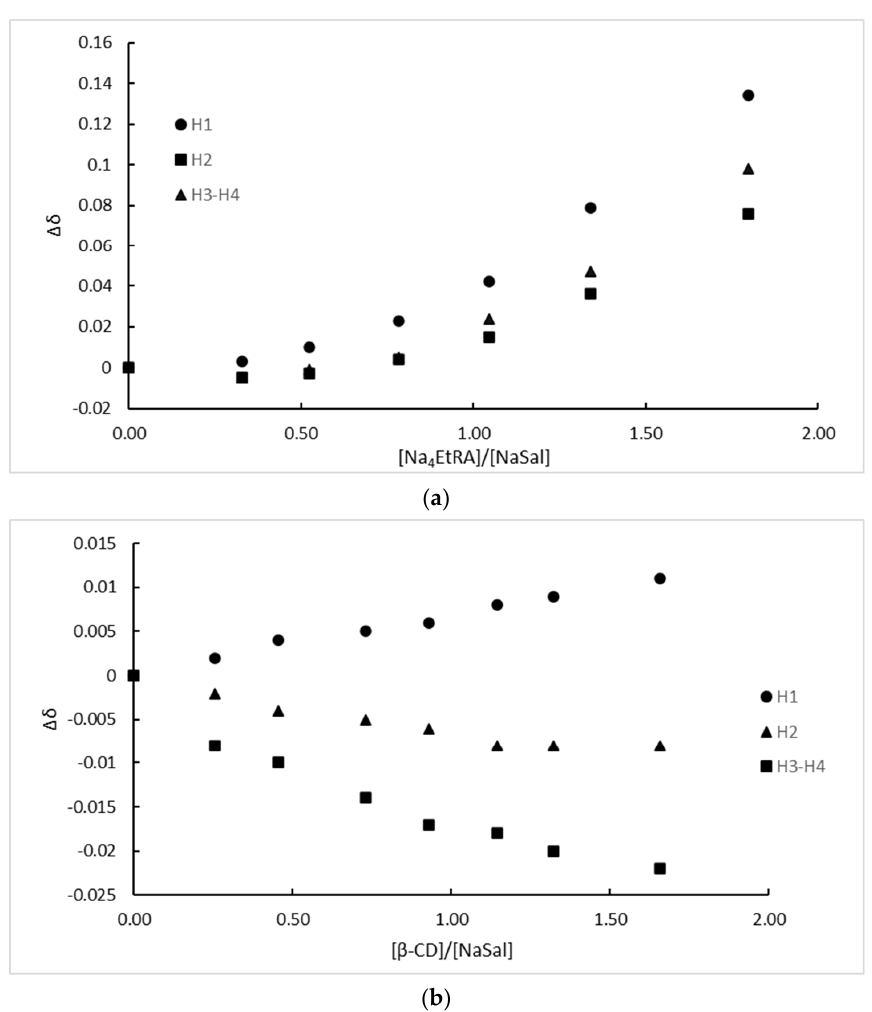
Figure 5. Chemical shifts as a function of the molar rate for ( a ) Na 4 EtRA-NaSal and ( b ) β -CD-Na- Sal.